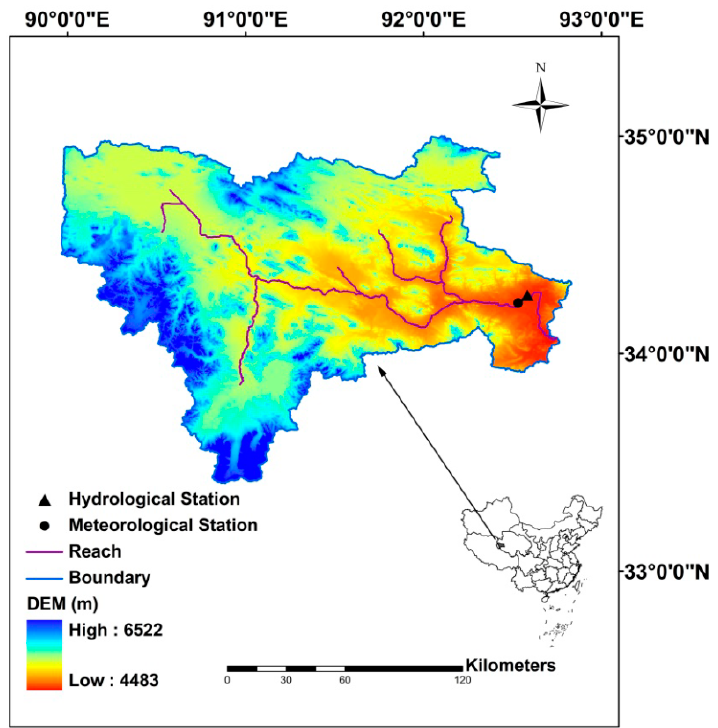
Figure 1. Location of the Tuotuo River basin.